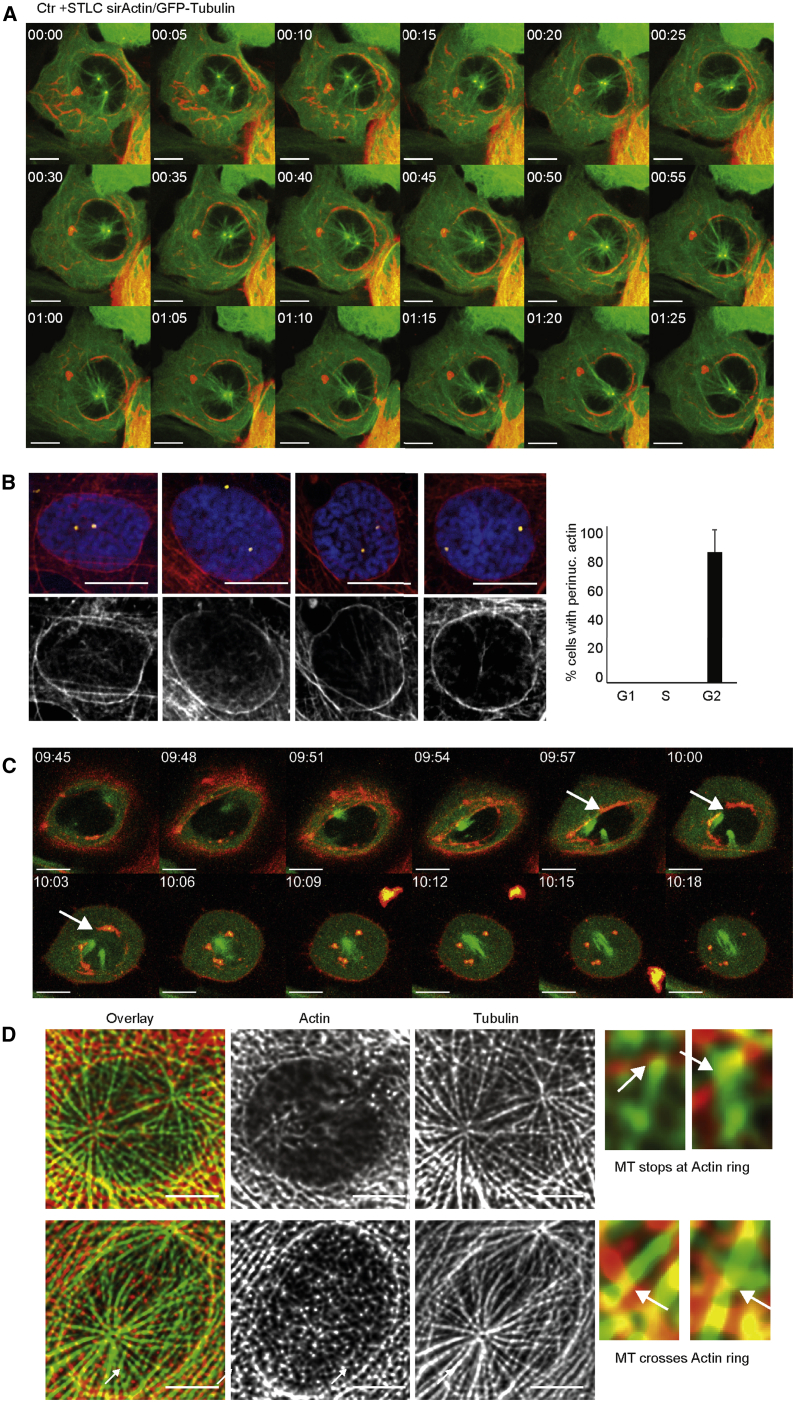
Prophase-Specific Perinuclear Actin Structures Coordinate Centrosome Positioning and Restrain Eg5-Dependent Separation(A) Perinuclear actin interacts with centrosomal MT asters (see also Video S6). Images from time-lapse video of centrosome congression following STLC treatment of 1NM-PP1-arrested U2OS cdk1as cells showing perinuclear actin structures (green, GFP-alpha-tubulin; red, SiR-actin; scale bar, 10 μm).(B) Phalloidin staining of G2/prophase-specific perinuclear actin in fixed U2OS cells. Images of fixed wild-type (WT) U2OS probed by immunofluorescence and phalloidin staining. The panels show examples of individual prophase cells. Top panels show overlays (phalloidin, red; gamma-tubulin, green; and DAPI, blue). The bottom panel shows the phalloidin staining (scale bar, 10 μm). The graph on the right shows the average percentage of cells with perinuclear actin structures in indicated cell-cycle phases (three experiments, n > 30, error bars indicate standard deviation).(C) G2/prophase-specific perinuclear actin in asynchronous U2OS cells detected by SiR-actin in living cells (see also Video S7). Images from a time-lapse movie in asynchronous U2OS cells showing formation of perinuclear actin structures in prophase (green, GFP-alpha-tubulin; red, SiR-actin; scale bar, 10 μm). See also Video S7.(D) Imaging of MT/actin interactions by SRRF processing. 1NM-PP1-arrested U2OS cdk1as cells were labeled by immunofluorescence and imaged using the SRRF technique. Phalloidin is shown in red and tubulin in green in the overlay. The smaller panels on the right show examples of MTs either stopping at or crossing the perinuclear actin ring. Scale bar, 5 μm.